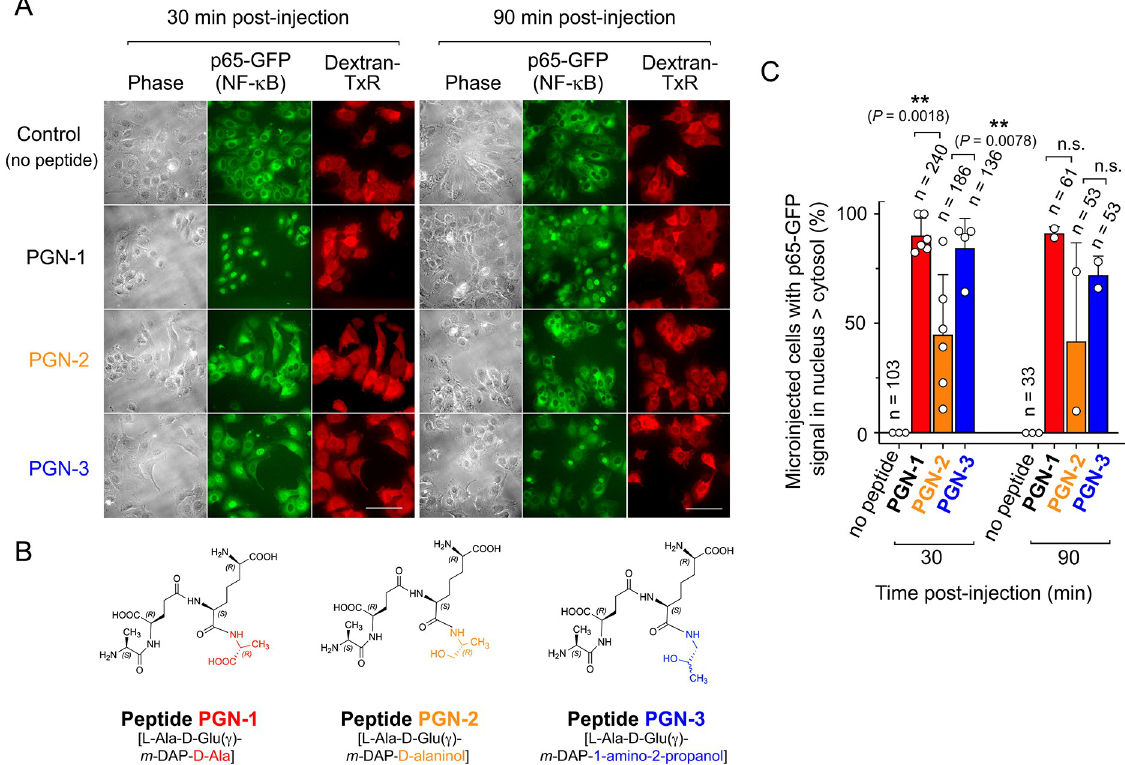
Fig 7. The presence of alaninol at the C-terminal residue of a canonical tetrapeptide (substituting D-Ala) attenuates stimulation of the pro-inflammatory regulator NF- κ B. (A) Images of mouse embryonic fibroblasts from knock-in mice expressing the reporter p65-GFP, with p65 being a subunit of NF- κ B. Dextran Texas Red was added to the peptide solution to identify at single-cell level the microinjected cells. Two post-injection times, 30 and 90 min, are shown. The images are of a representative assay of a minimum of three independent biological replicates. Bar, 10 μ m. (B) Structure of the three synthetic tetrapeptides used, PGN-1, PGN-2 and PGN-3. (C) Quantification of the percentage of microinjected cells having a higher p65-GFP signal in nucleus versus the cytosol. The circles are quantifications corresponding to independent biological replicates with n referring to the total number of microinjected cells examined. Bars show median and standard error values. �� , P = 0.001 to 0.01; n.s., not significant, by one way ANOVA with multiple comparisons.